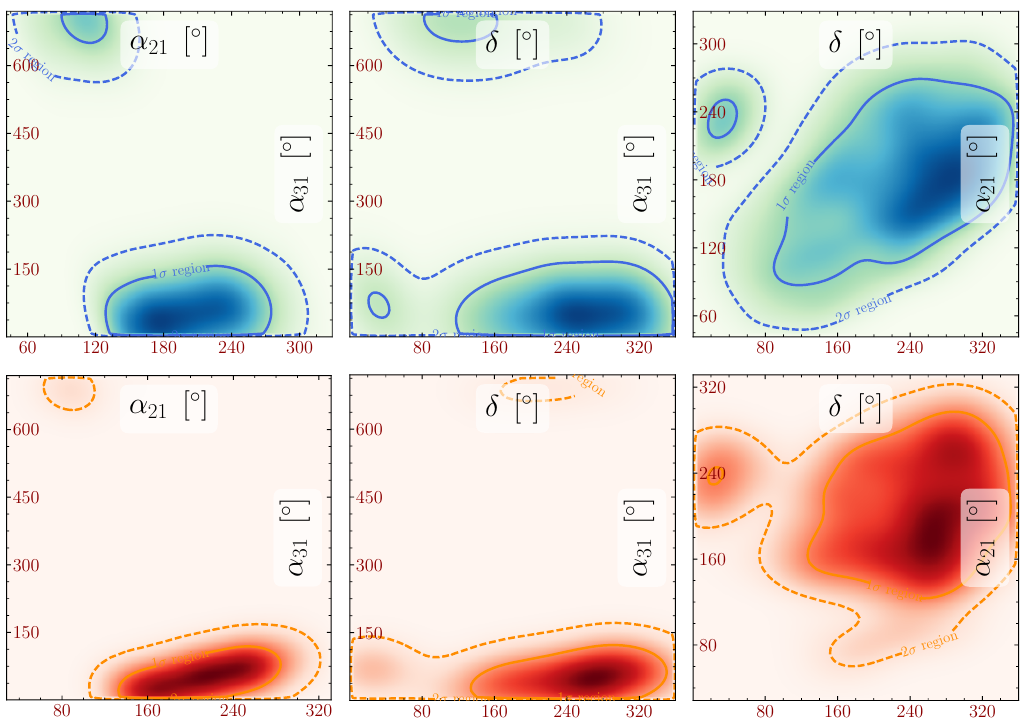
Figure 8 . The two-dimensional projections for intermediate scale leptogenesis with M 1 = 3 : 16 10 6 GeV for x 1 = 0, y 2 = 0, x 3 = 180 (cid:14) , y 1 = y 2 = 180 (cid:14) , with CP violation provided only by the phases of the PMNS matrix. The normal ordered case is coloured blue/green and inverted ordering orange/red and contours correspond to 68% and 95% con(cid:12)dence levels. This plot was created using SuperPlot